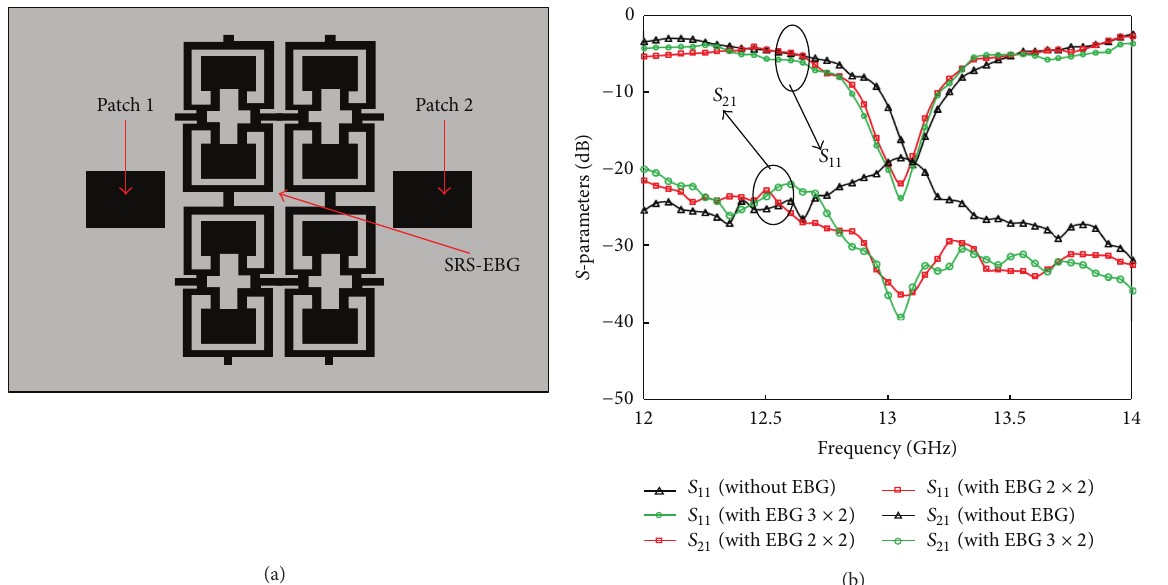
Figure 27: (a) Microstrip antenna array with SRS-EBG structure and (b) simulated 𝑆 -parameters of array with and without proposed EBG